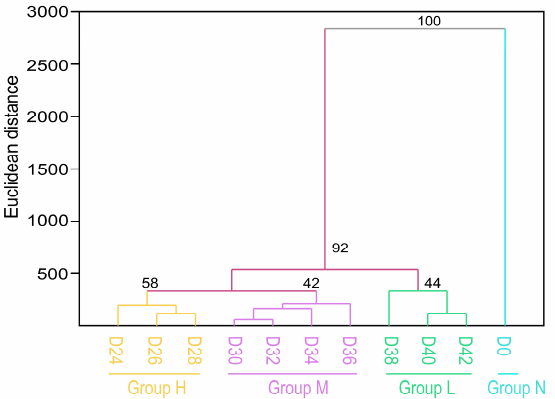
Figure 11. UPGMA clustering diagram based on Euclidean distance of 48 indicators. All eleven oat seed samples were classified into three distinct groups, non-aged group (Group N), higher vigor group (Group H), medium vigor (Group M), and lower vigor group (Group L).